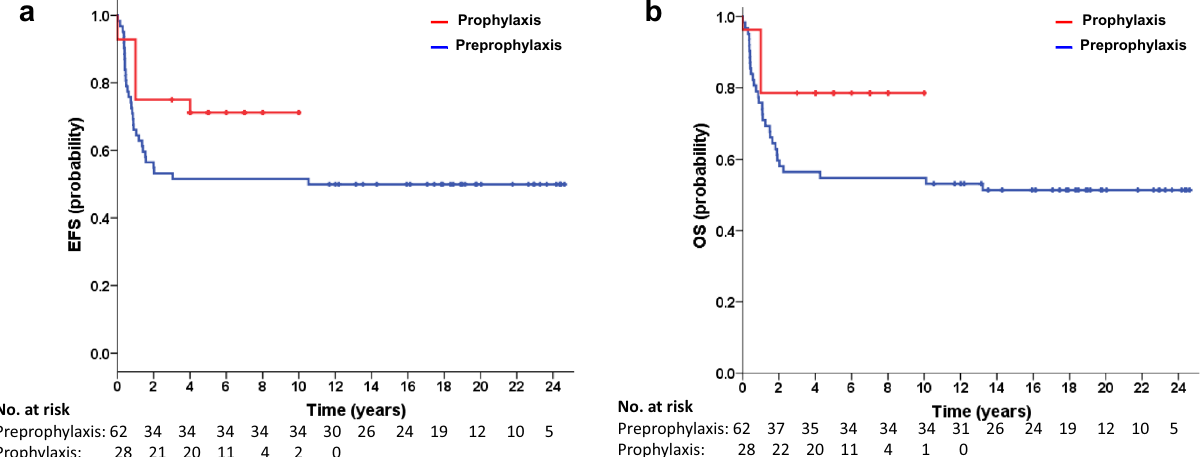
Figure 2. Outcome according to treatment arm. ( a ) Probability of event-free survival (EFS). ( b ) Probability of overall survival (OS) are shown.